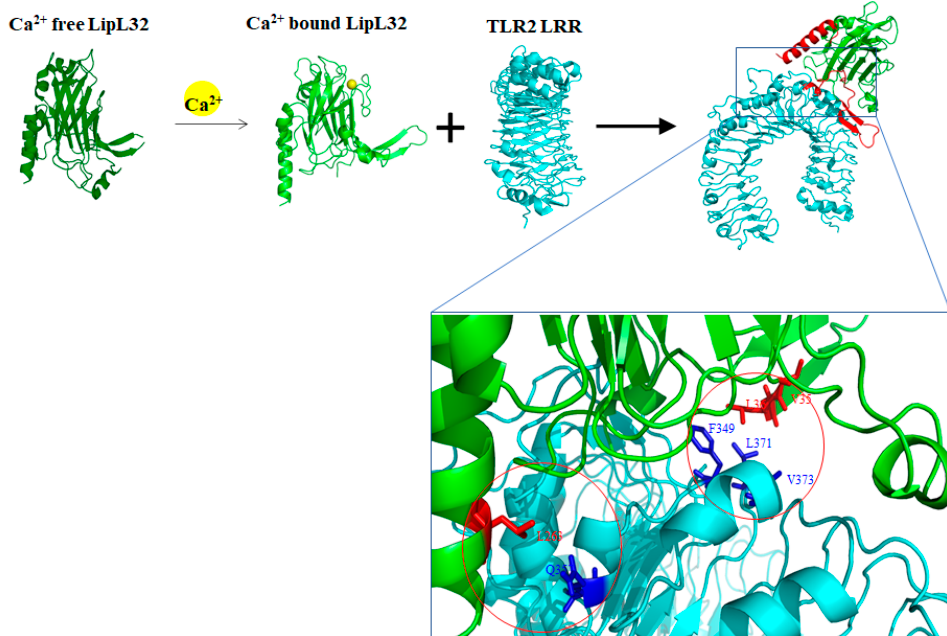
Figure 2. The proposed model of LipL32 and TLR2 interactions. Calcium ion-induced conforma- tional changes of LipL32 and regulated the affinity of LipL32 to TLR2. The Ca 2+ bound LipL32 interacted with TLR2 and the domains and residues involved in the dimer formation were evaluated. The TLR2 LRR domain is shown in cyan and the LipL32 in green as well as the two termini of LipL32 in red.